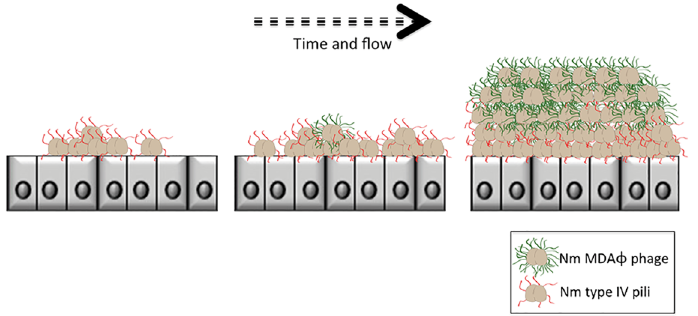
Fig 8. Proposed model for the role of MDA Φ bacteriophage in the commensal lifecycle of Nm . Type IV pili are representedin red and bacteriophage in green. After the initial adhesion mediated by type IV pili, bacteriamultiply and loose piliation.On the other hand, bacteriain direct contact with the host cells remained piliated.Phageproductionis activated in the upper layers of the biomassand bacteriophages, which remain in part attached to the bacterial surface, form bundleswhich stabilize bacteria/bacteria